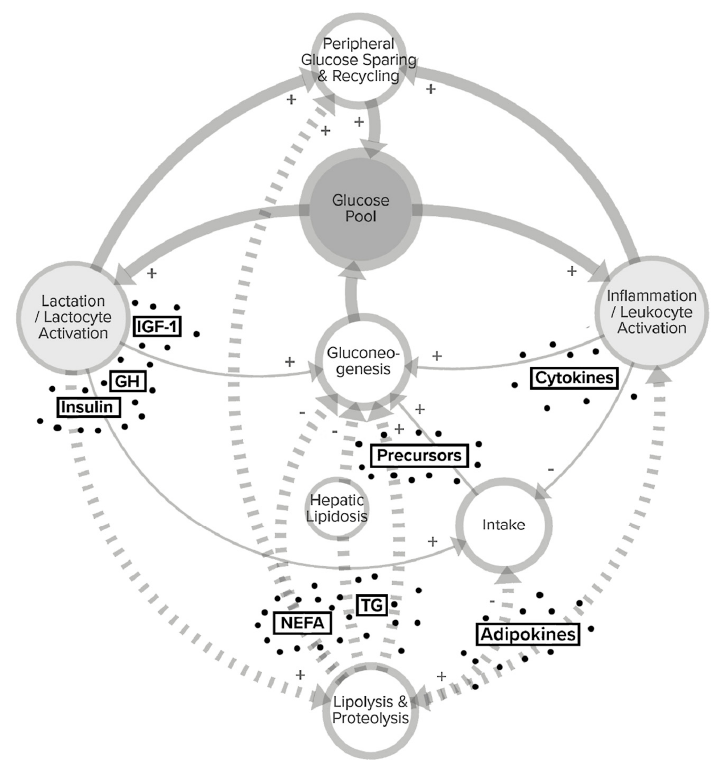
Figure 1. Schematic representation of metabolic pathways related to the glucose balance of dairy cows during lactation and inflammation. Milk synthesis and immune defense rely on an adequate supply with glucose, as it is an important energy source and precursor for lactocytes and leukocytes. To increase overall glucose availability to the respective cell type, inflammatory signals (cytokines) as well as peripartal fluctuation of hormones associated with the somatotropic axis such as growth hormone (GH), insulin and insulin-like growth factor 1 (IGF-1) enhance ( + ) the rate of gluconeogenesis and a ff ect the level of intake (solid lines, thin), and increase the mobilization of body reserves (dashed arrows). Lipolysis and proteolysis provide endogenous glucose precursors such as alanin and glycerol as well as alternative energy sources like non-esterified fatty acids (NEFA) that help spare glucose in peripheral tissues, where insulin sensitivity is reduced. Because glucose uptake is non-dependent on insulin in both leukocytes and lactocytes, trade-o ff s for glucose allocation (solid arrows, bold) may arise in situations where inflammation and lactation impose high demands. Limitations may also arise from negative e ff ects (-) of adipokines and cytokines on the hypothalamic regulation of intake and from hepatic accumulation of triglycerides (TG) and NEFA when lipolysis is